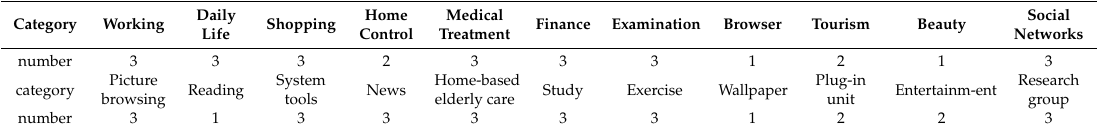
Table 7. Categories of the app test set.